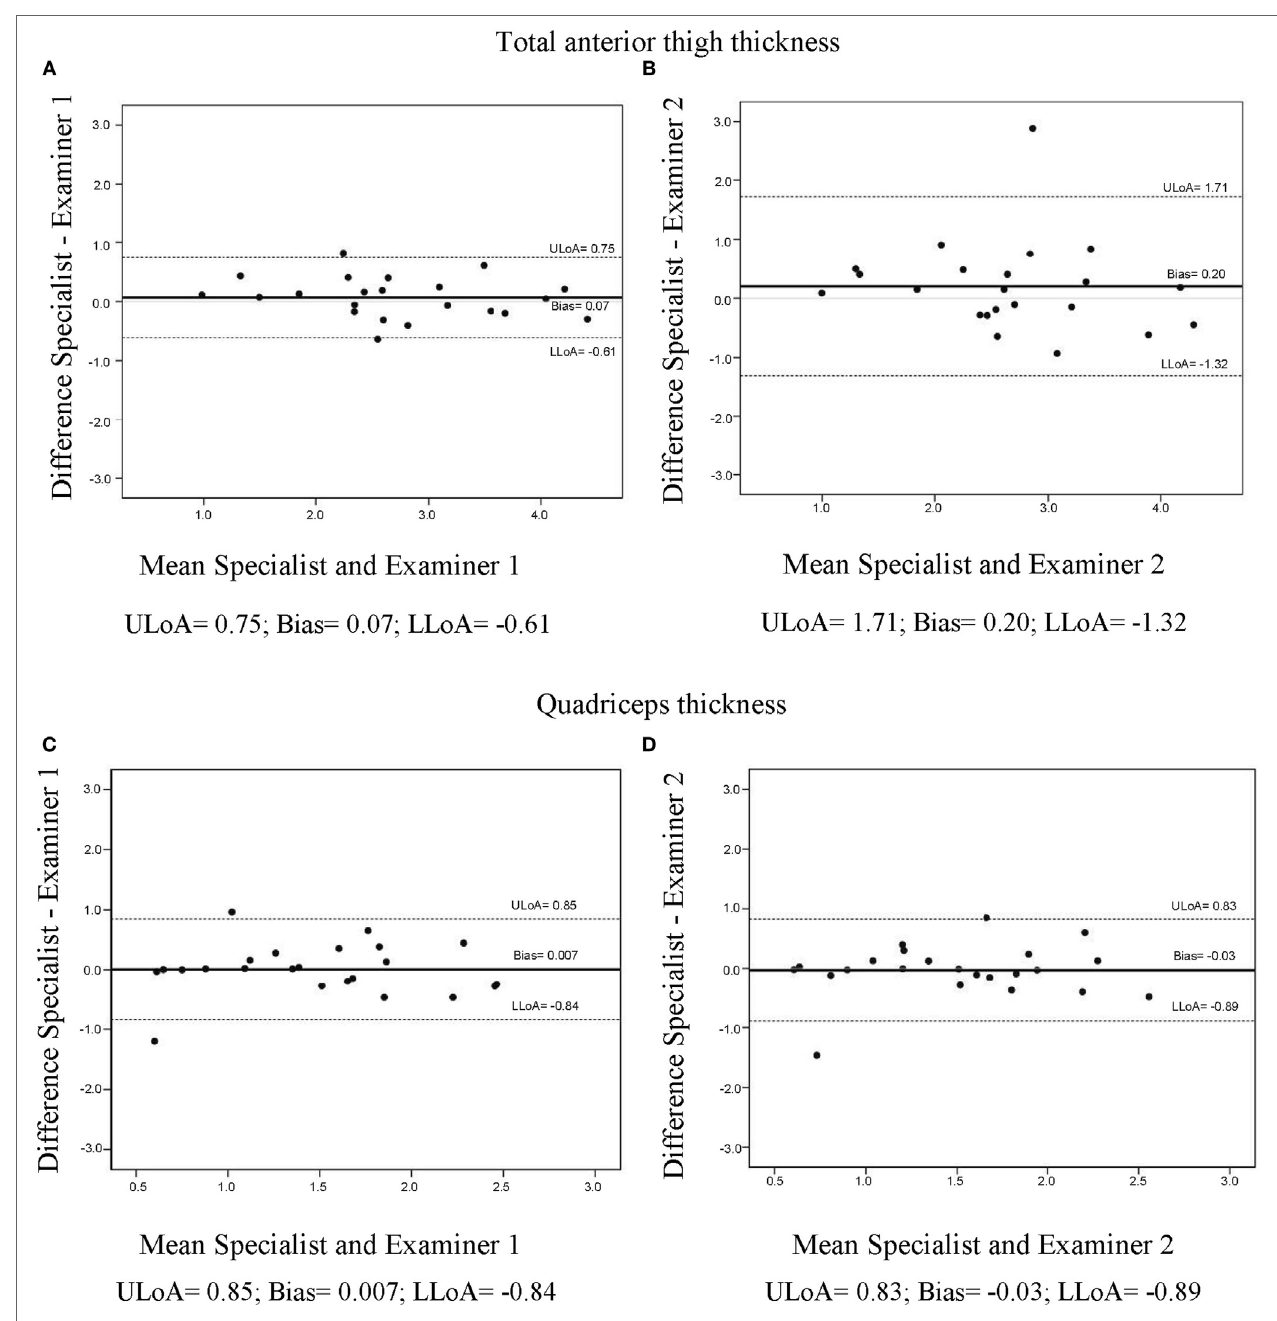
FigUre 2 | Bland–Altman interobserver agreement analysis for total anterior thigh thickness (a,B) and quadriceps thickness (c,D) . ULoA, upper limit of agreement; LLoA, lower limit of agreement